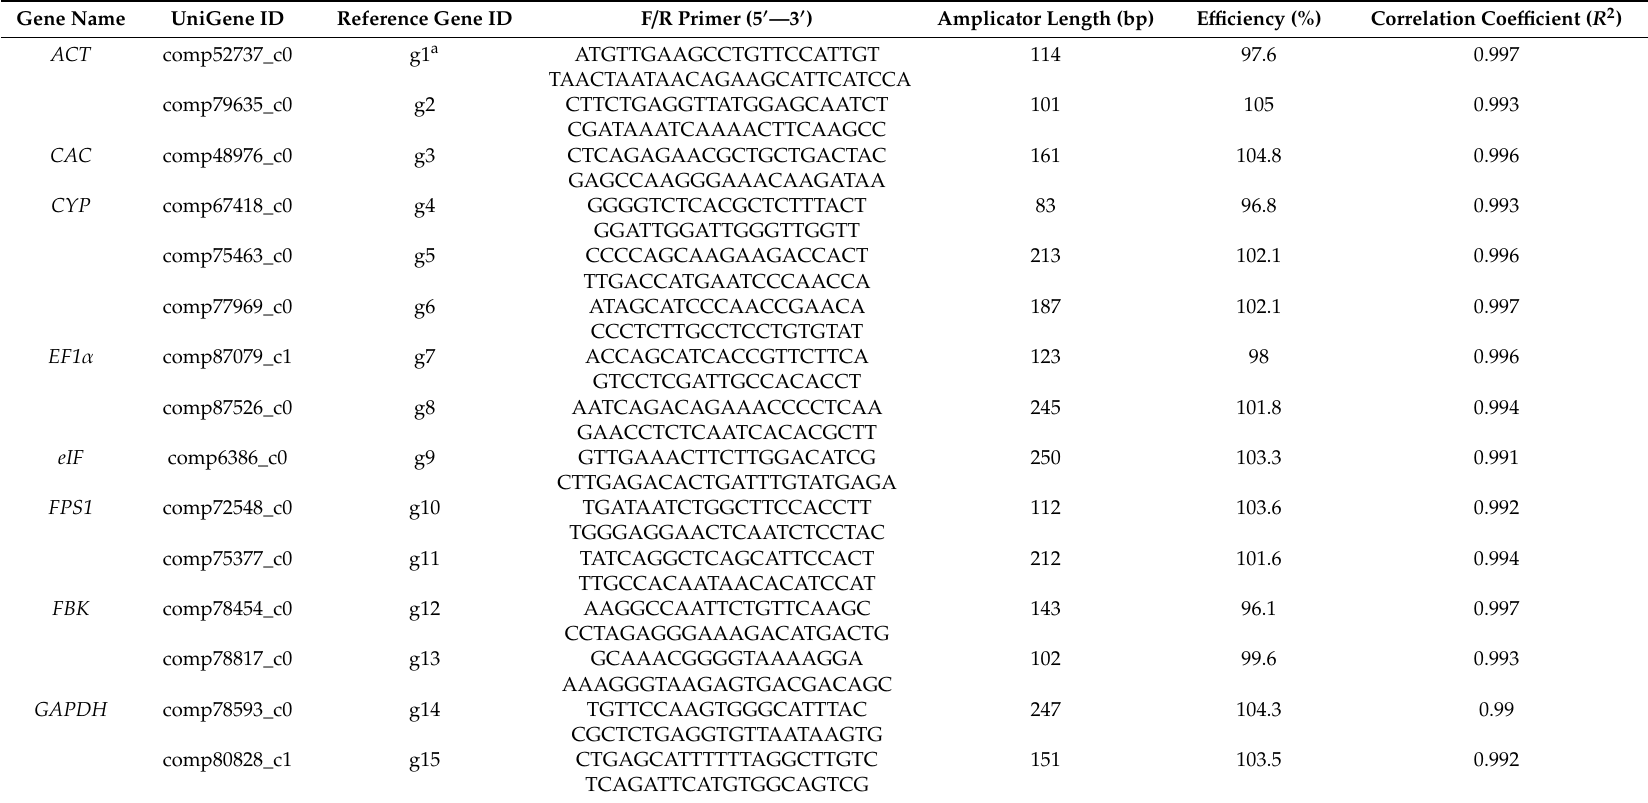
Table 1. Selected candidate reference genes, primers, and amplicon